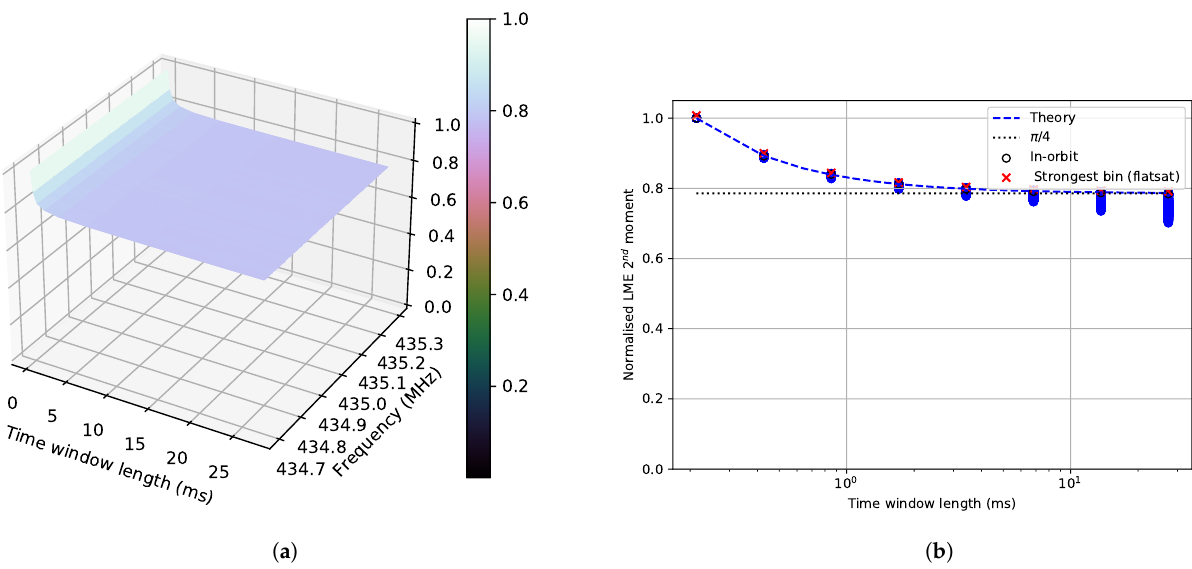
Figure 7. Time behaviour of measurements over non-populated areas. ( a ) Normalised LME second moment for different time windows in 3D. ( b ) Normalised LME second moment for different time windows in